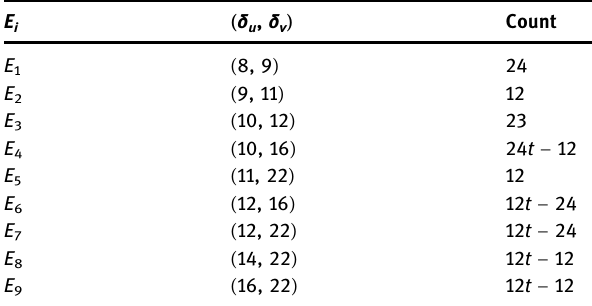
Table 3: Closed neighbourhood degree sum - based edge partitions of MOF 1 ( t )